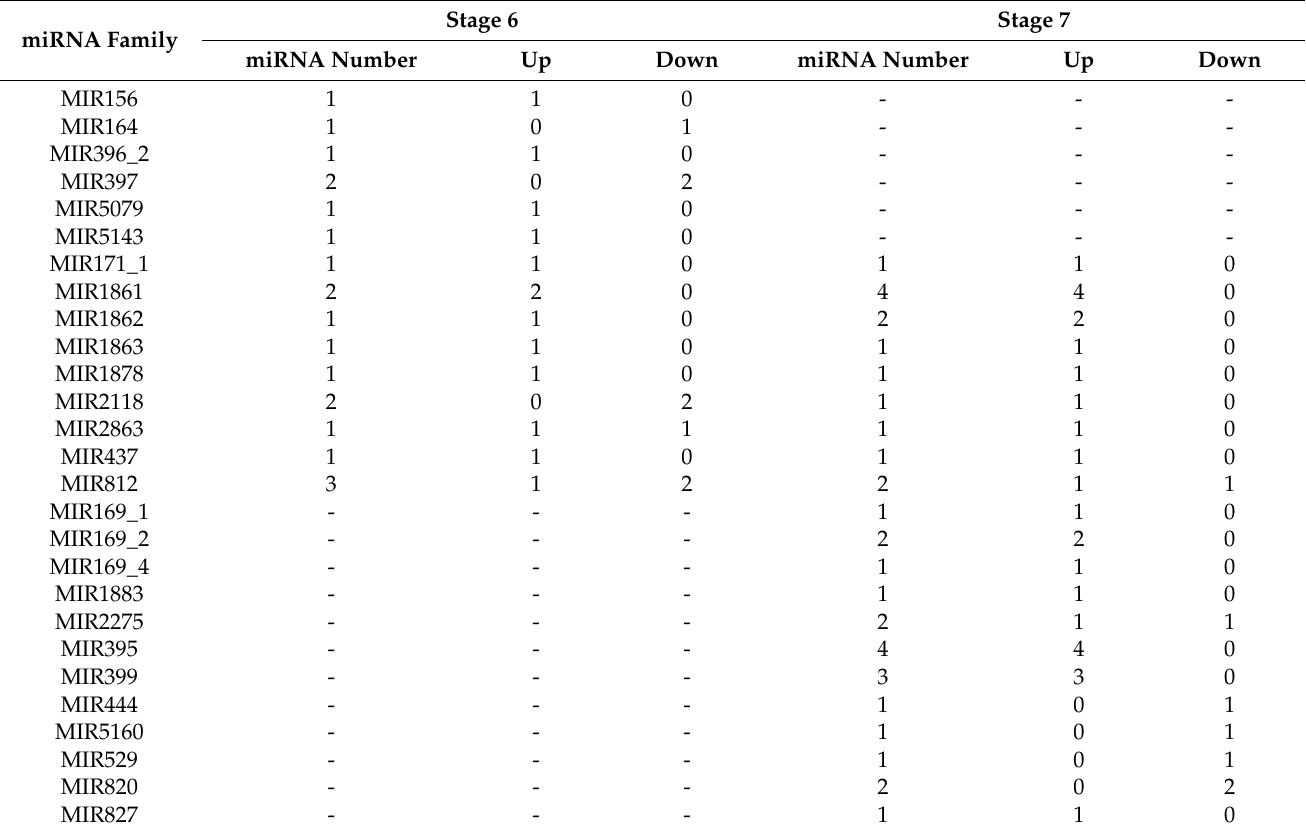
Table 2. Significantly differentially expressed miRNA families of